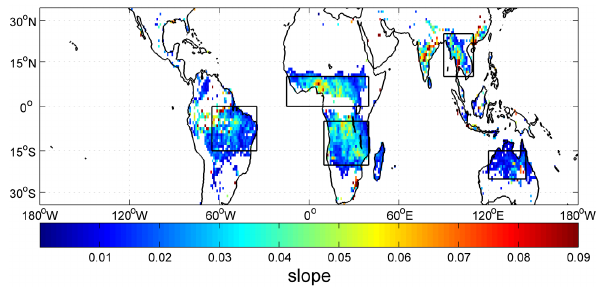
Figure 6. Mean gradients [in units of 10 15 molecules cm -2 (mW m -2 ) -1 ] of the best fitting least- 2 Fig. 6. Mean gradients (in units of 10 15 moleculescm − 2 squares regression lines (2007-2011) for pixels with r > 0.3, based on a 1° x 1° grid. Data are 3 (mWm − 2 ) − 1 ) of the best fitting least-squares regression lines shown for GOME-2 TVC NO 2 vs. MODIS Terra FRP linear relationships. 4 (2007–2011) for pixels with r >0.3, based on a 1 ◦ × 1 ◦ grid. Data are shown for GOME-2 TVC NO 2 vs. MODIS Terra FRP linear